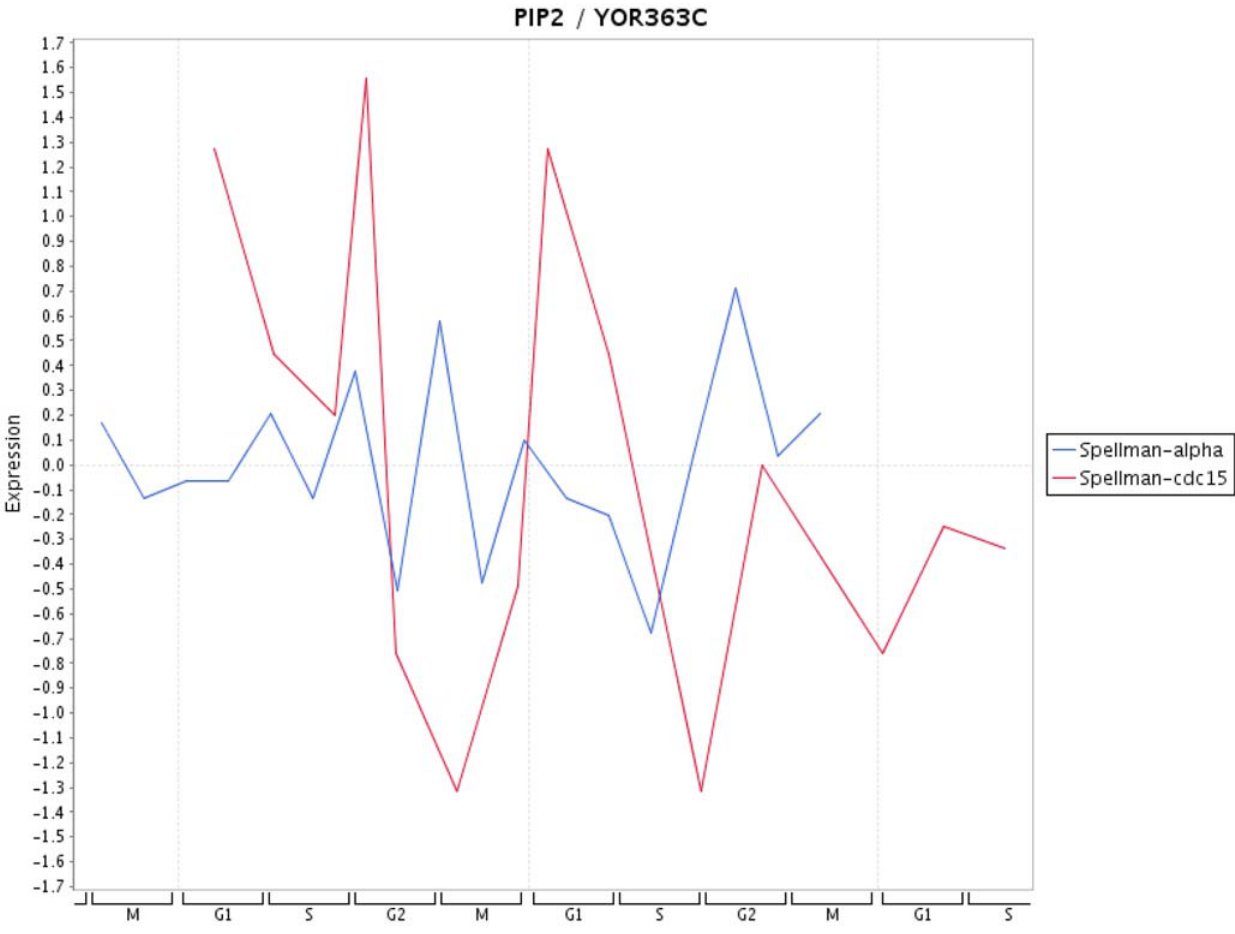
Figure 12. Expression profile for PIP2 for time series data from S PELLMAN et al. [ 32 ] .